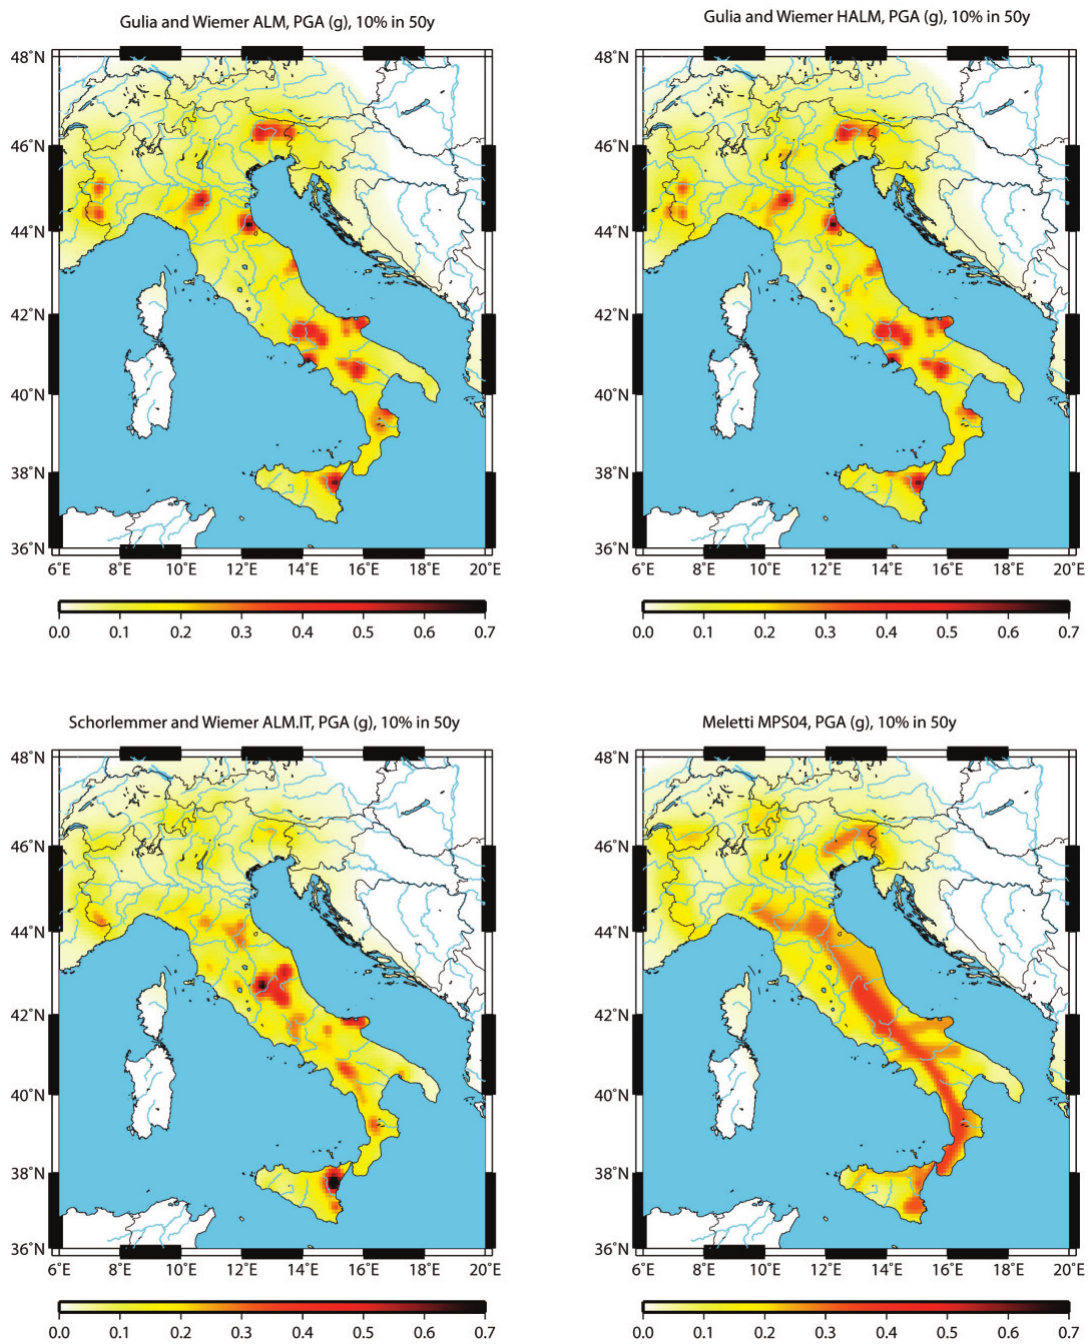
Figure 10. Hazard maps in terms of peak ground acceleration in percent of g for the ALM (top, left), the HALM (top, right) and the ALM.IT (bottom, left), along with a simplified version of the MPS04 (bottom, right) [MPS Working Group 2004]. Forecast rates of each model at each grid node were used, with a single ground-motion prediction equation and computed at the 10% in 50 year probability levels using